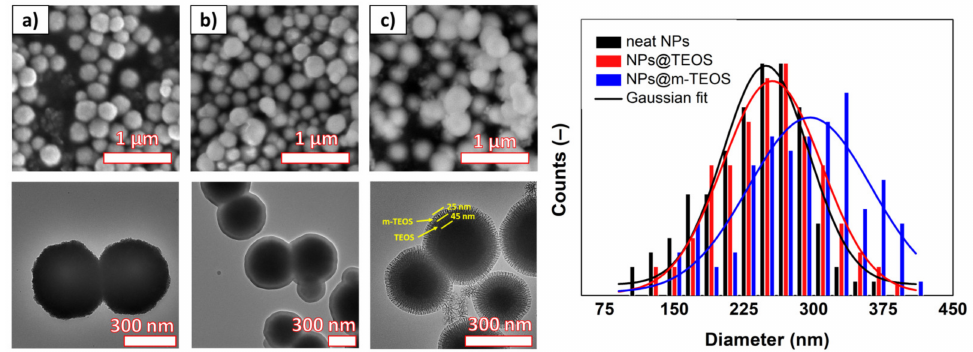
Figure 1. SEM/TEM images of the ( a ) neat NPs, ( b ) NPs@TEOS and ( c ) NPs@m-TEOS, and the particle-size distributions for the corresponding nano-species.